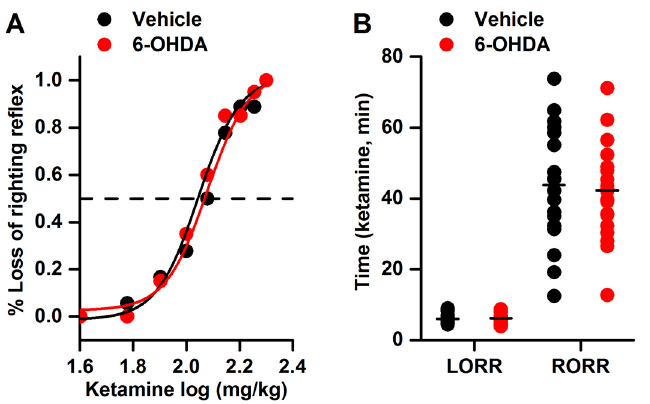
Fig 4. The effects of the bilateral lesioning of the dopaminergic VTA neurons on the ketamine ED50 value and the times of onset of and recovery from ketamine anesthesia. 6-OHDA: 6-hydroxydopamine; LORR: loss of the righting reflex; RORR: return of the righting reflex. P > 0.05 vs . vehicle; n = 18 for the vehicle group and n = 20 for the 6-OHDA group.